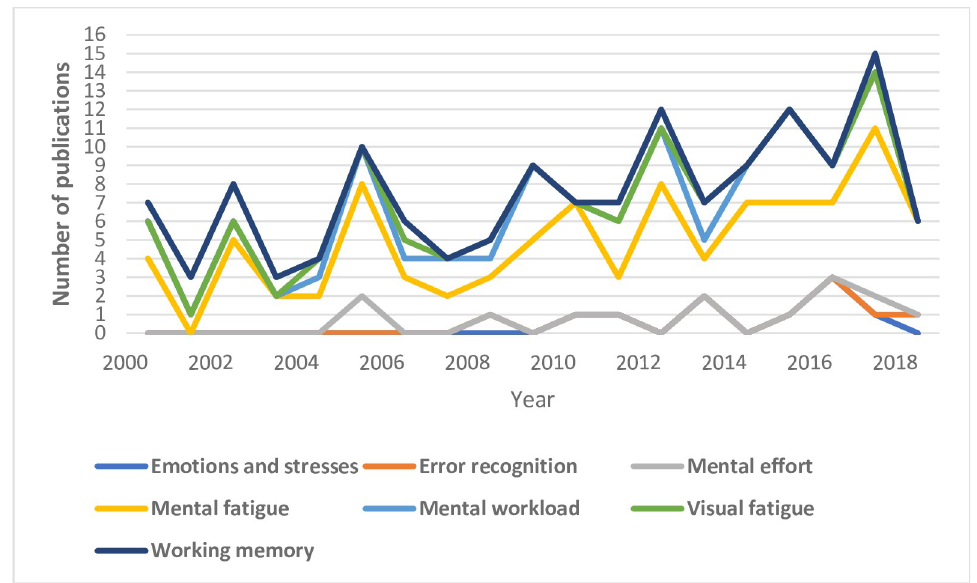
Fig 11. Temporal trends of the number of publications on each of the seven themes.